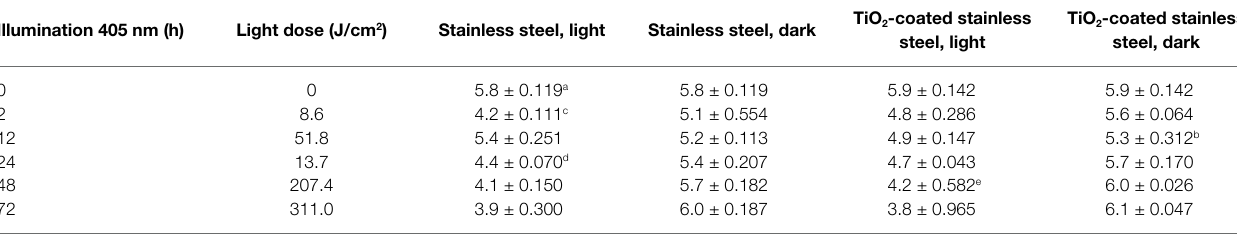
TABLE 1 | Number of Listeria monocytogenes on stainless steel plates after 0–72-h 405 nm light illumination at +5 ± 2 ° C. Illumination 405 nm (h) Light dose (J/cm 2 ) Stainless steel, light Stainless steel,